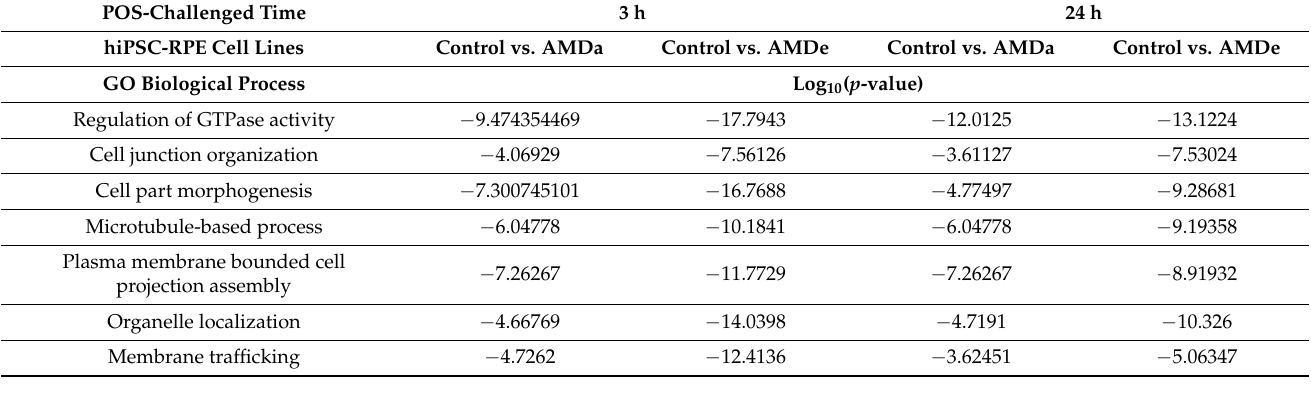
Table 1. Comparison between hiPSC-RPE Control (N = 6), AMDa (N = 6) and AMDe (N = 3) cells of selected Gene Ontology biological processes involved in 3 and 24 h POS challenged.